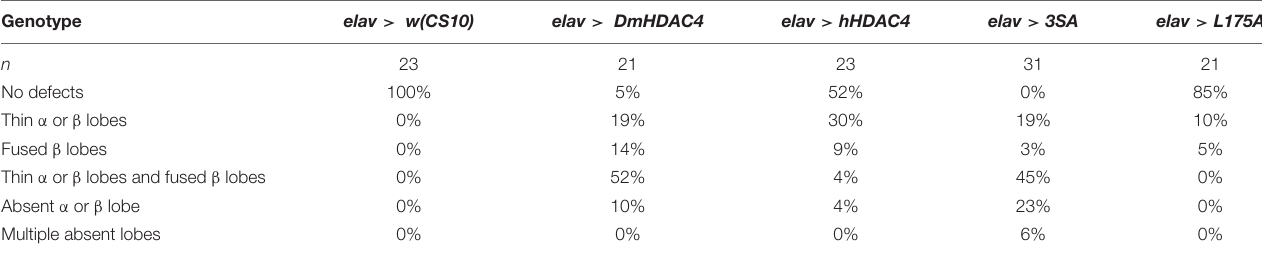
FIGURE 2 | Nuclear accumulation of HDAC4 disrupts mushroom body development. Immunohistochemistry with anti-FasII and anti-GFP antibodies on whole mount brains expressing FLAG-tagged HDAC4 variants and CD8::GFP as a counterstain to visualize all the lobes. All images are frontal confocal projections through the mushroom body region of the brain. All genotypes were generated by crossing elav-GAL4; UAS-CD8::GFP females to males carrying each UAS-HDAC4 transgene and to the w(CS10) control. Brains displaying representative phenotypes are shown. Scale bar = 50 µ m. α , β , and γ lobes of the mushroom body are labeled in white. Thin and fused β lobes ( ∧ ) are evident in a brain expressing DmHDAC4 . A brain expressing hHDAC4 appears normal. Missing α lobe (arrow) and fused β lobes ( ∧ ) are evident in a brain expressing 3SA . A brain expressing L175A appears normal. TABLE 1 | Frequency of mushroom body phenotypes resulting from expression of HDAC4